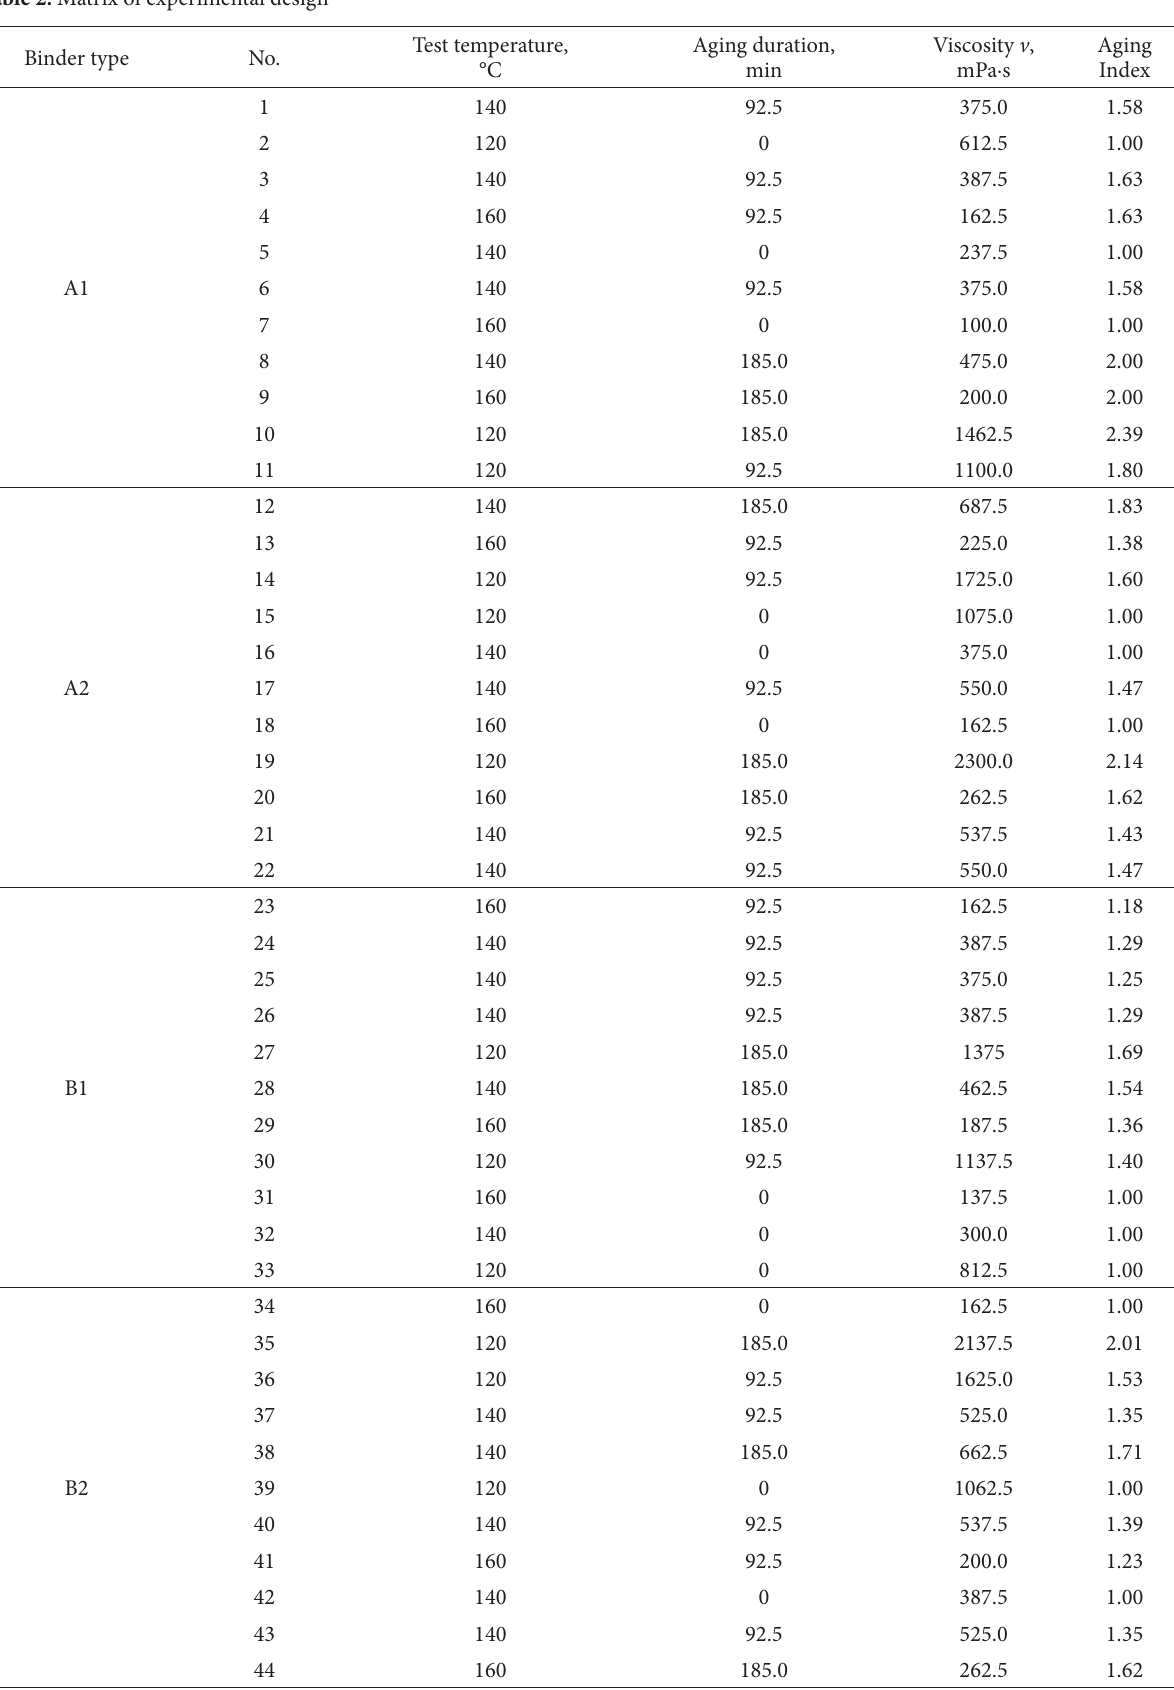
Table 2. Matrix of experimental design Binder